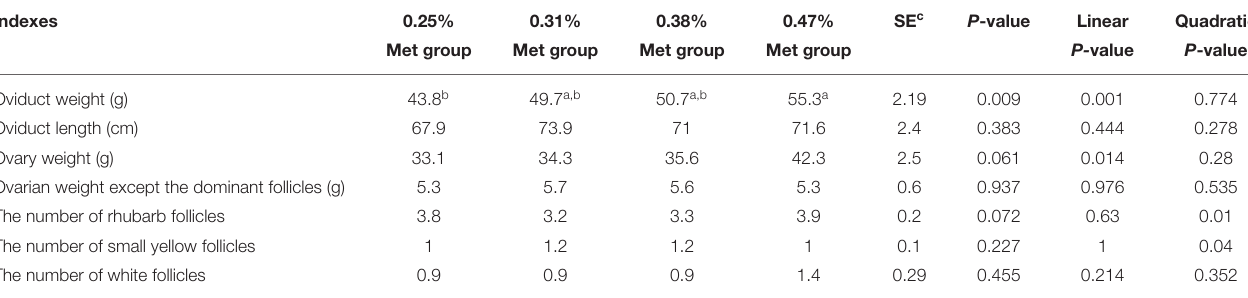
TABLE 4 | The effects of different dietary Met supplementation in low protein diets on the reproductive system of laying hens that are 38–50 weeks. Indexes 0.25% 0.31% Linear Quadratic Met group Met group